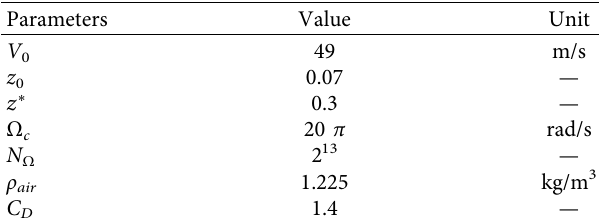
Figure 12: Typical wind hazard realization at the top floor of the building: (a) wind speed and (b) wind load time series. Table 10: Parameters for the stochastic wind